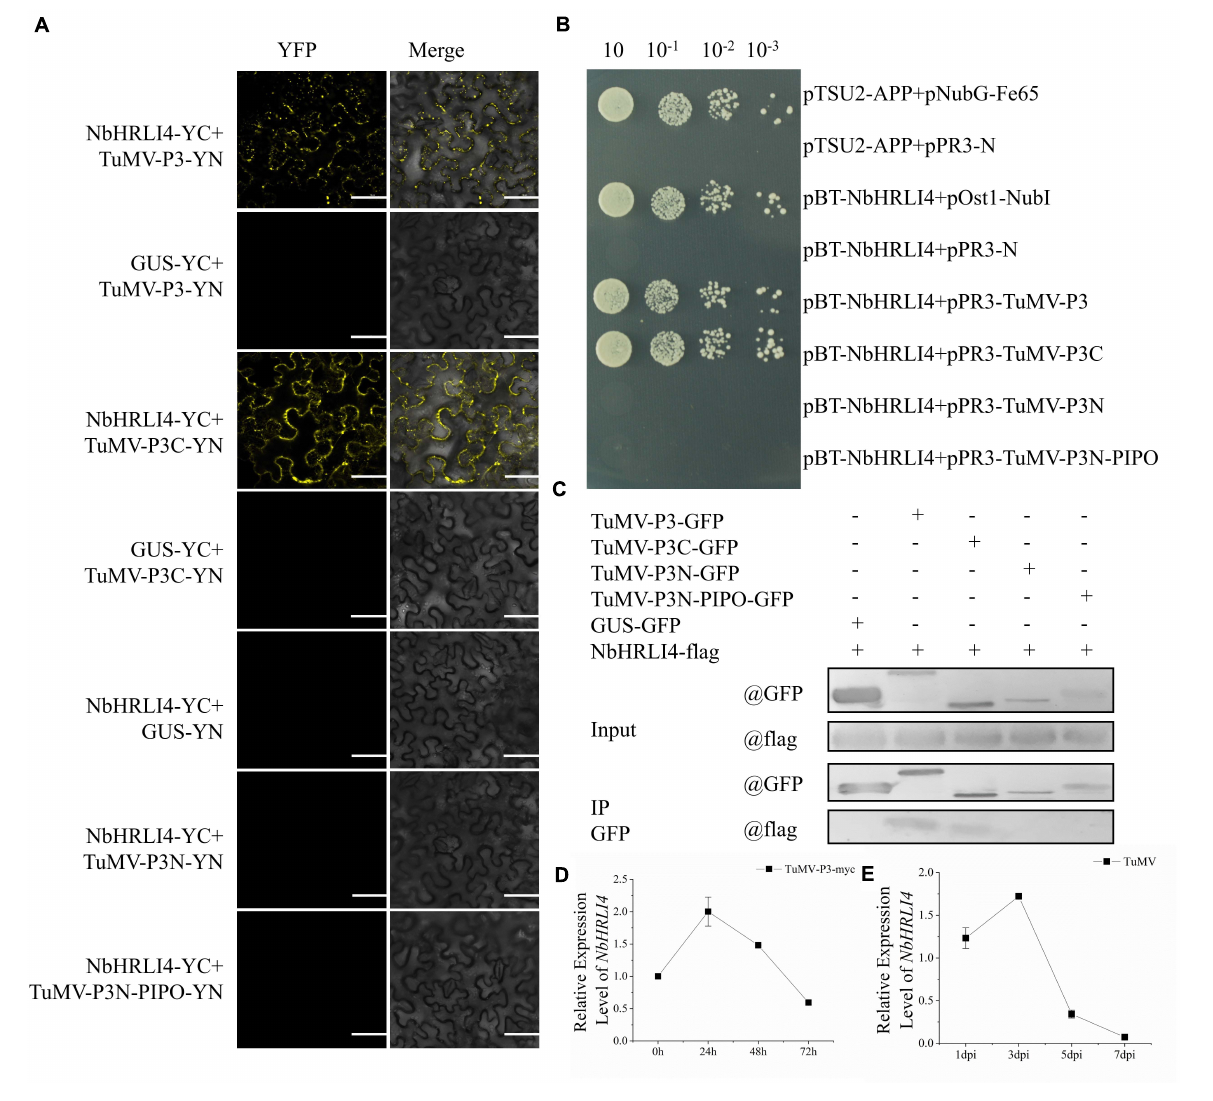
FIGURE 7 | NbHRLI4 interacted with TuMV-P3 and responded to the expression of TuMV-P3. (A) BiFC assays were conducted between NbHRLI4/TuMV-P3, NbHRLI4/TuMV-P3C, NbHRLI4/TuMV-P3N, and NbHRLI4/TuMV-P3N-PIPO. GUS was used as negative control. Bars = 50 µ m. (B) Y2H assays between pBT-NbHRLI4/pPR3-TuMV-P3, pBT-NbHRLI4/pPR3-TuMV-P3C, pBT-NbHRLI4/pPR3-TuMV-P3N, and pBT-NbHRLI4/pPR3-TuMV-P3N-PIPO. pBT-NbHRLI4 with pPR3-N was used as negative control and pBT-NbHRLI4 with pOst1-NubI was the positive control. (C) CO-IP assays between NbHRLI4-flag/TuMV-P3-GFP, NbHRLI4-flag/TuMV-P3C-GFP, NbHRLI4-flag/TuMV-P3N-GFP, and NbHRLI4-flag/TuMV-P3N-PIPO-GFP. NbHRLI4-flag with GUS-GFP was the negative control. (D) RT-qPCR detection of NbHRLI4 mRNA in the inoculated leaves at different times (0, 24, 48, and 72 h) of P3-myc expression. (E) RT-qPCR detection of NbHRLI4 mRNA in the systemic leaves at different times (1, 3, 5, and 7 days) after TuMV